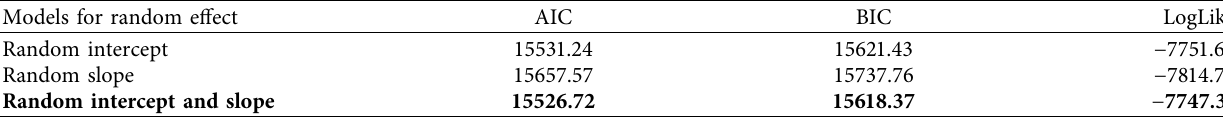
Table 4: Selection of random effects to be included in the LMM.